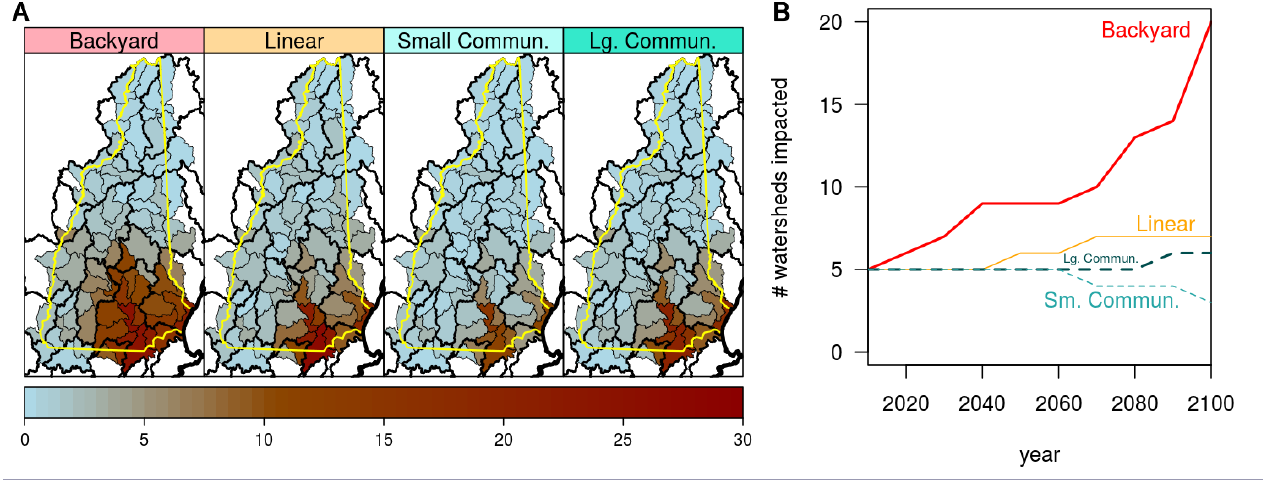
Fig. 5. Proportion (%) impervious cover by HUC10 watershed for 2100 for each scenario (A) and changes in number of impacted watersheds (> 10% impervious cover) contained in or overlapping the state (B).